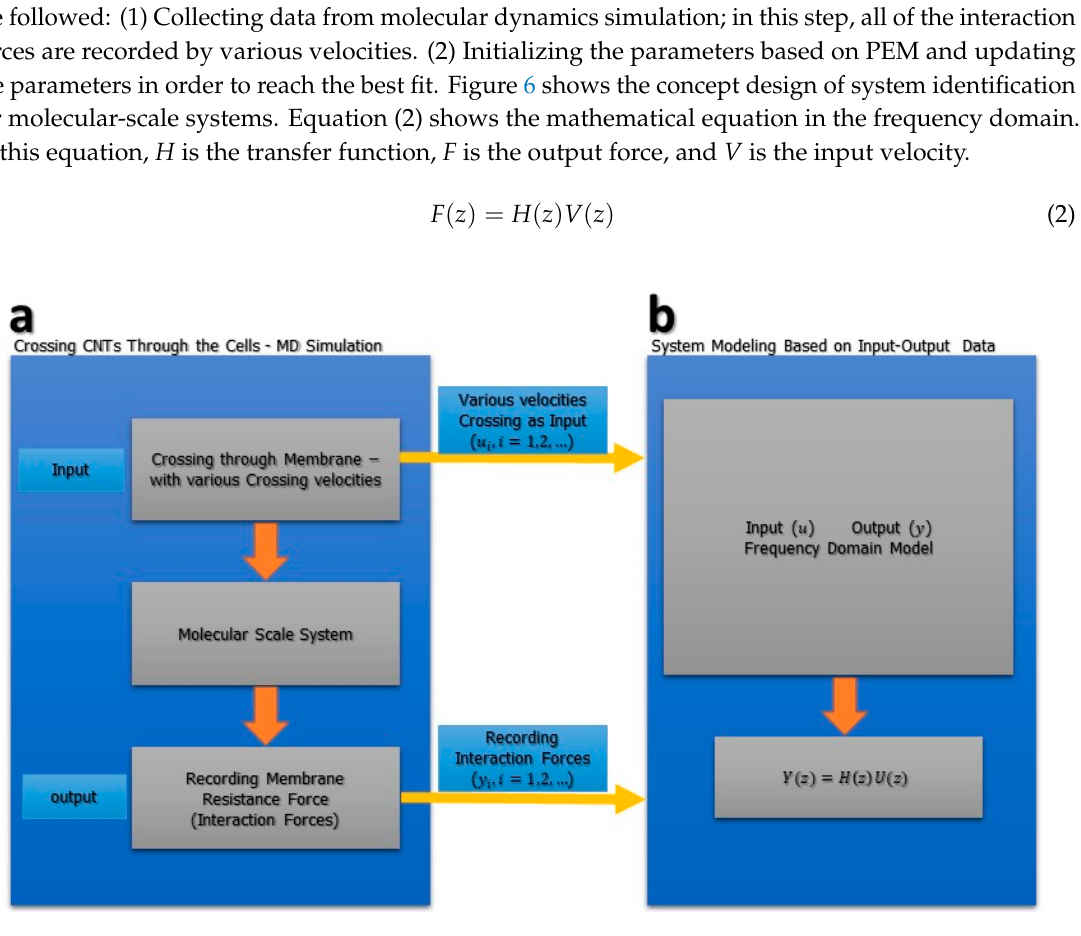
Figure 6. Concept of frequency domain modelling of the molecular-scale system. ( a ) Based on the designed molecular-scale model, functionalized CNTs cross through the lung cell membrane with various velocities and the interaction forces are recorded, which can be seen as a resistance force. ( b ) With the recorded interaction forces as the output and the velocity as the input, a frequency domain mathematical model is fitted on the data. The PEM system, parameters, and coefficient will be updated, and the desired parameters are extracted.